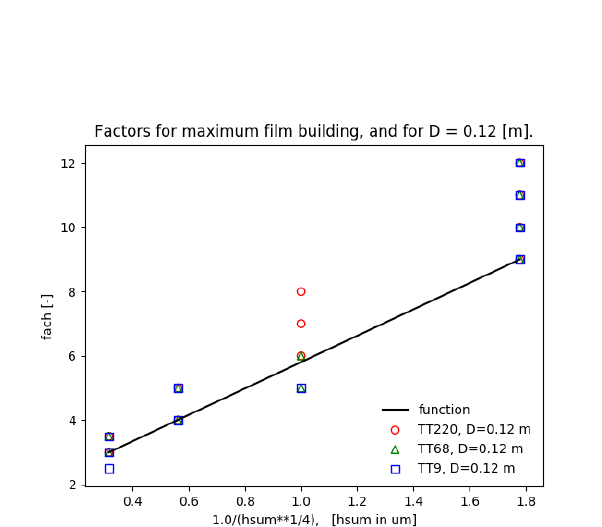
Figure 4: The film factors which gave maximum film for D = 0 . 12 m. The developed function is also shown.